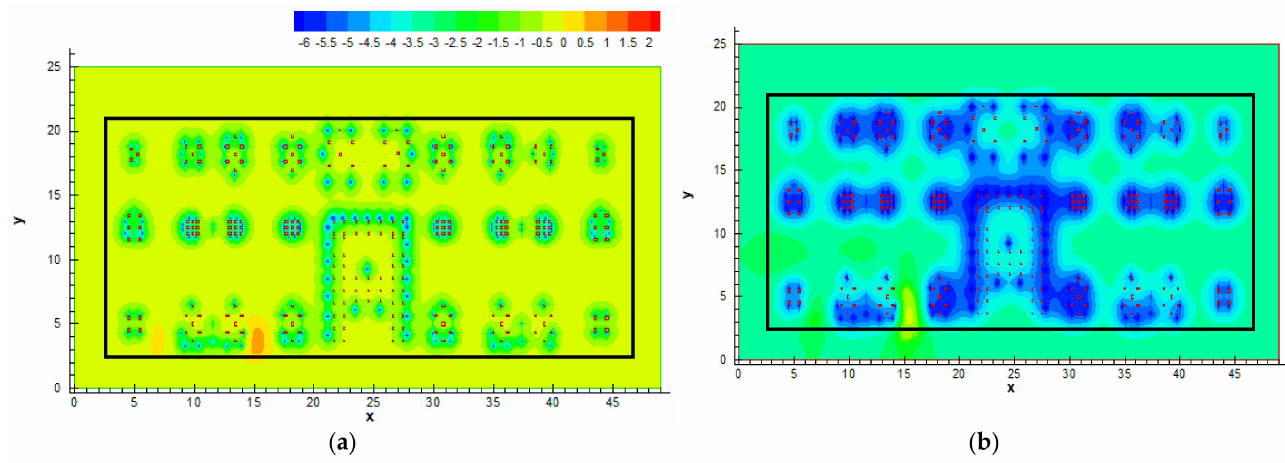
Figure 4. Temperature field at the depth of 2.3 m under Building I in December 2020 ( a ) and January 2021 ( b ) in the { x , y } plane.